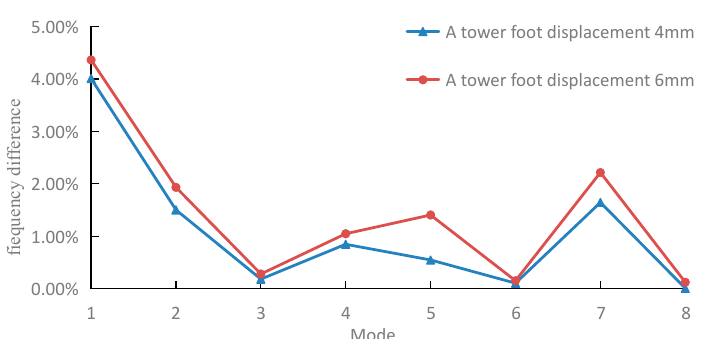
Figure 9. Change rate of modal frequency in the Y direction of the tower foot A before and after settlement.